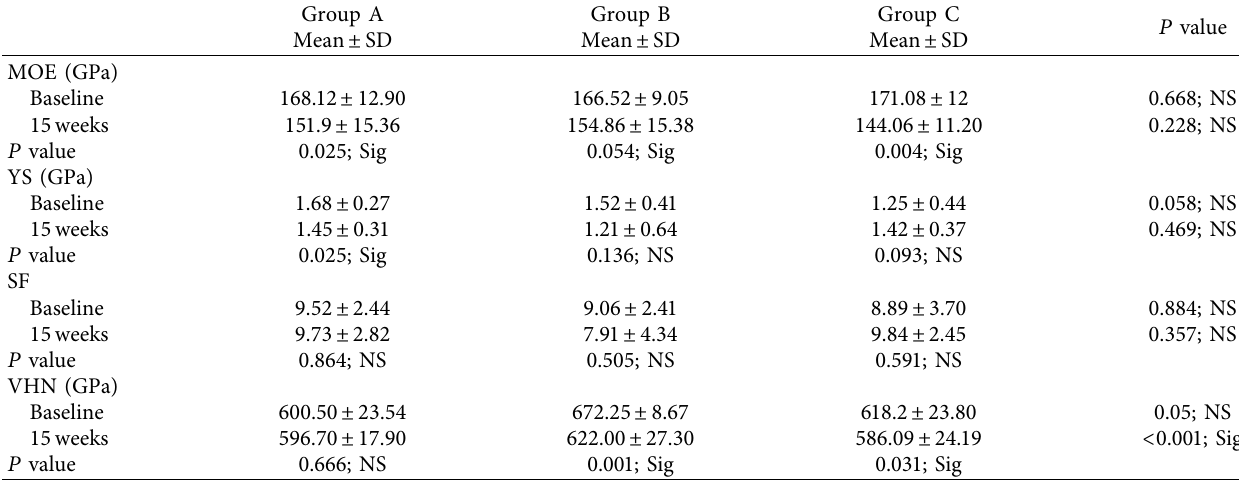
Table 2: Comparison of modulus of elasticity, yield strength, spring factor, and VHN.